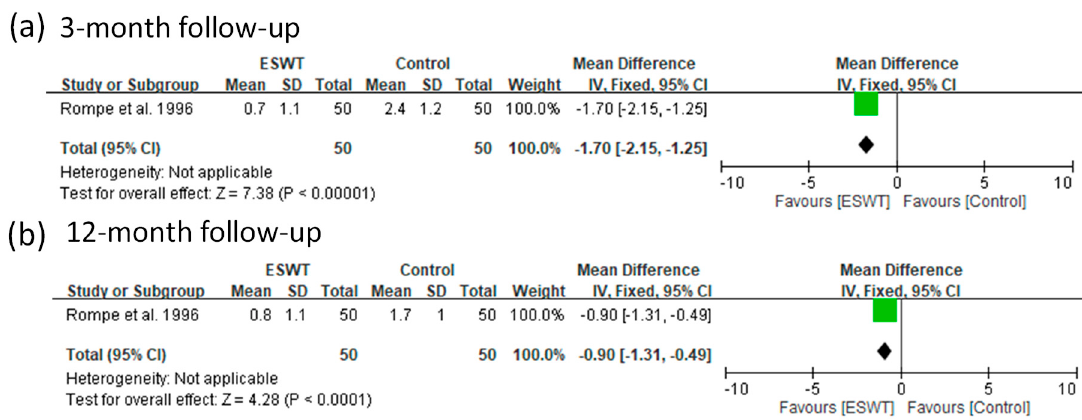
Figure 9. Forest plots of visual analog scale (VAS) scores in low-energy ESWT and placebo-controlled groups at 3-month ( a ) and 12-month ( b ) follow-ups.